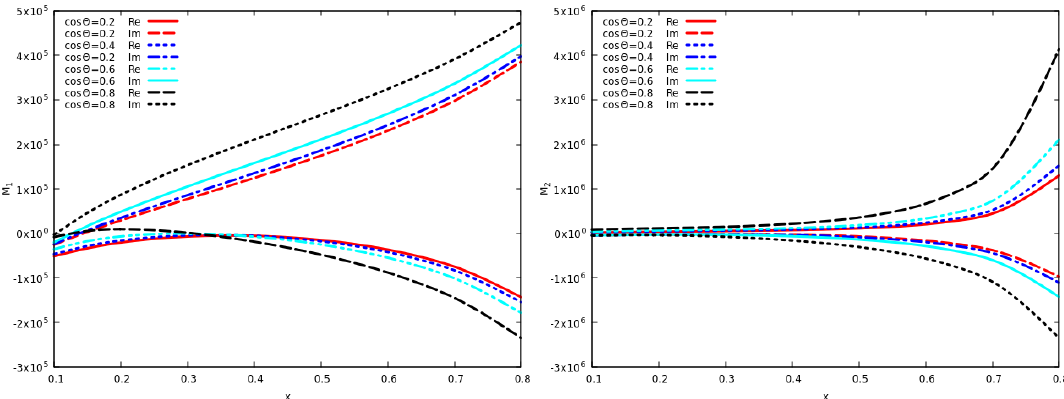
Figure 4 . Finite part of the two loop amplitudes for projector 1, M 1 = M (2) ; (cid:12)n = M (0) (left panel) 1 ;GG 1 ;GG and projector 2, M 2 = M (2) ; (cid:12)n = M (0) (right panel), suitably normalised, have been plotted as a 2 ;GG 2 ;GG function of x , for di(cid:11)erent values of cos (cid:18) . In the left panel, lines on the top half, corresponds to imaginary (Im) part of the amplitude and in the lower half corresponds to the real (Re) part of the amplitude. The trend is reverse in the right panel for M 2